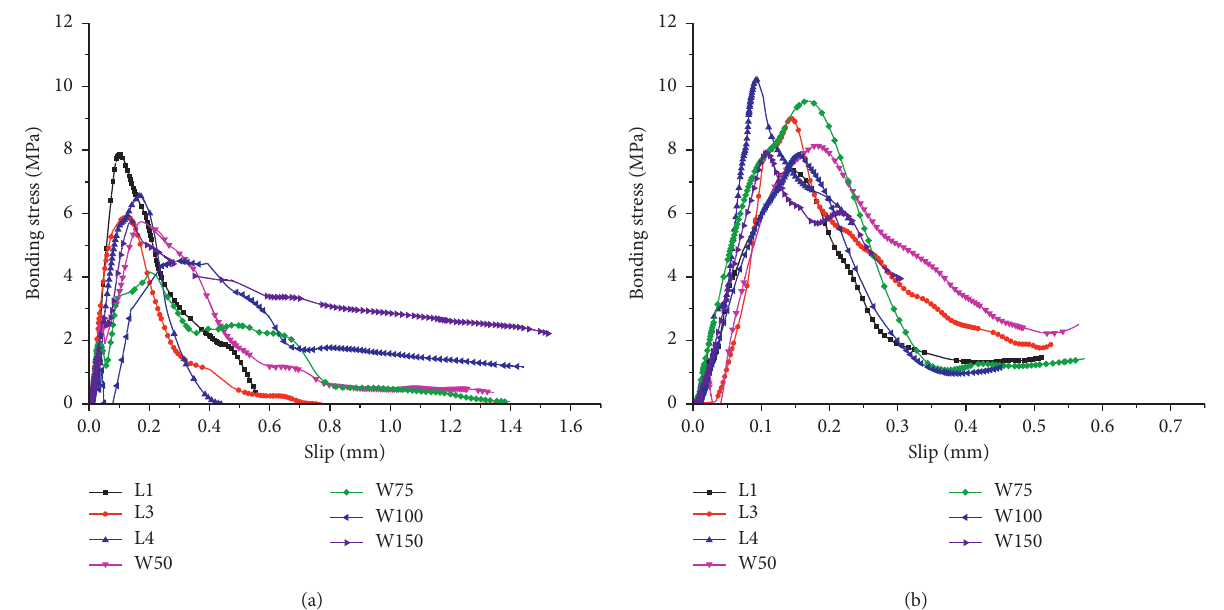
Figure 8: Bonding stress-slip curve of the (a) nonanchored area and (b) anchored